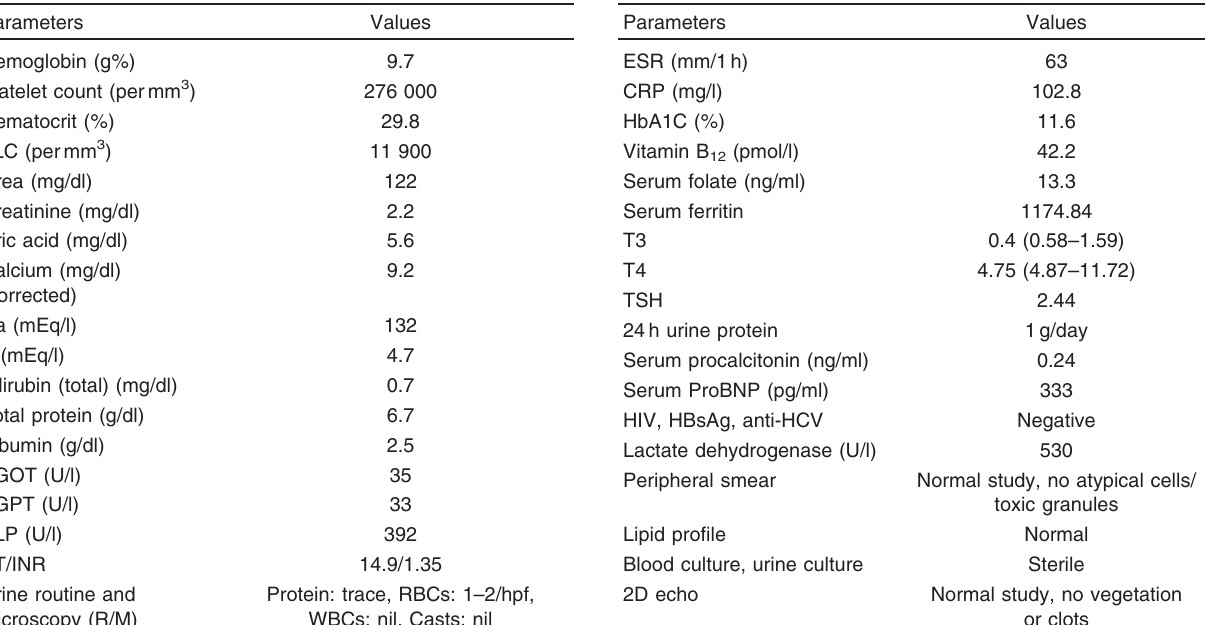
Table 1 Laboratory parameters at